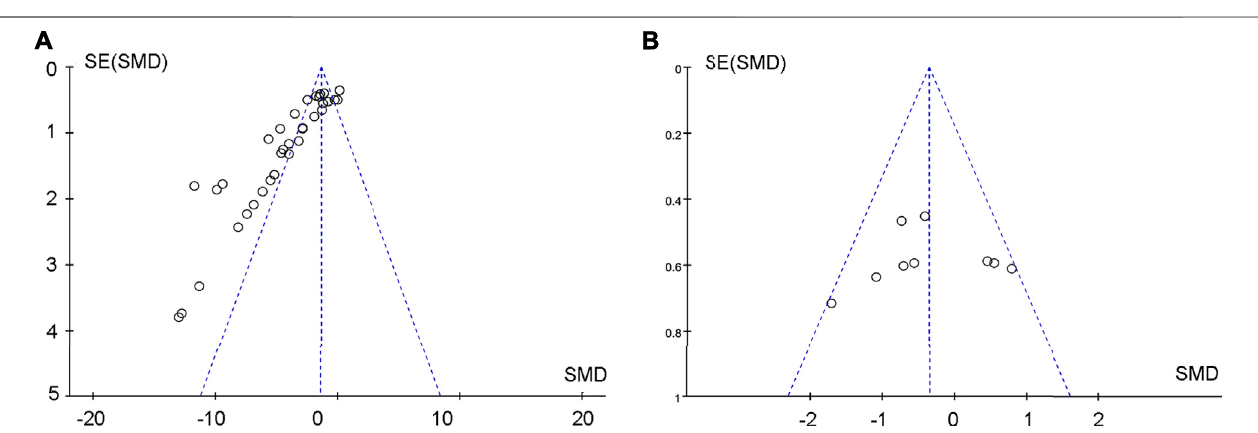
FIGURE 11 | Public bias of the effects of (A) TP and (B) TP versus RAS inhibitors on DKD.